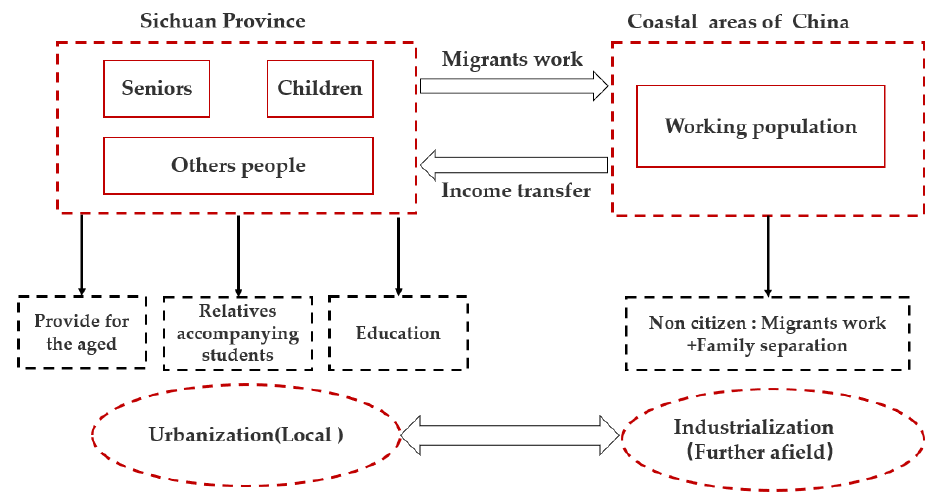
Figure 7. Schematic diagram of the mode in which migrant workers in Sichuan drive the local population to migrate to cities and towns.